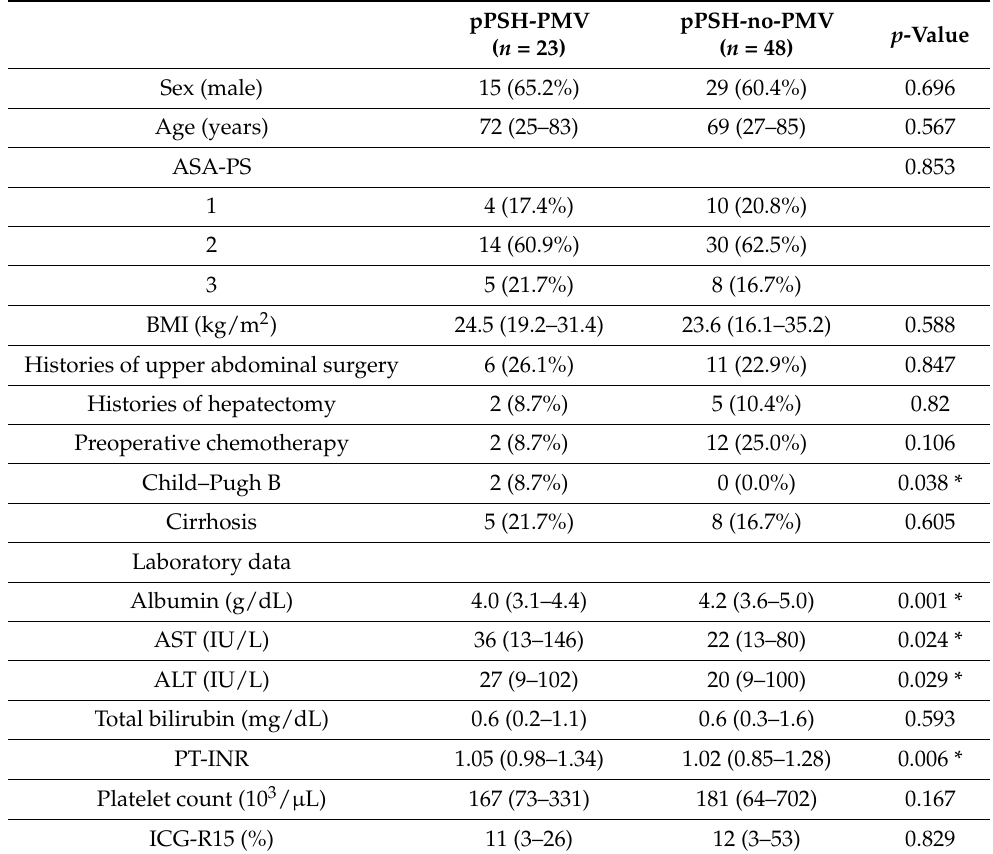
Table 7. Characteristics of patients that underwent pure laparoscopic PSH for one tumor lesion with PMV in PSS 7 and